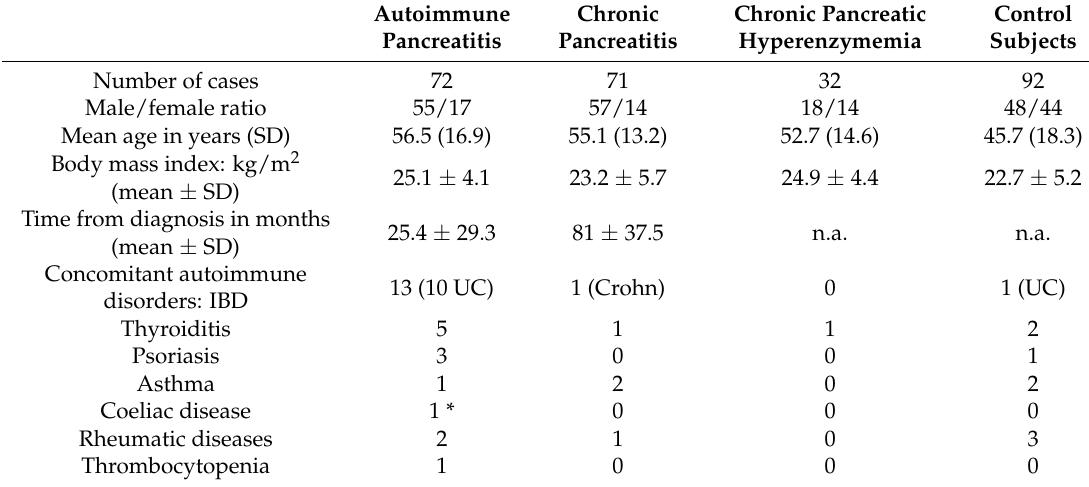
Table 1. Demographic and clinical features of the study